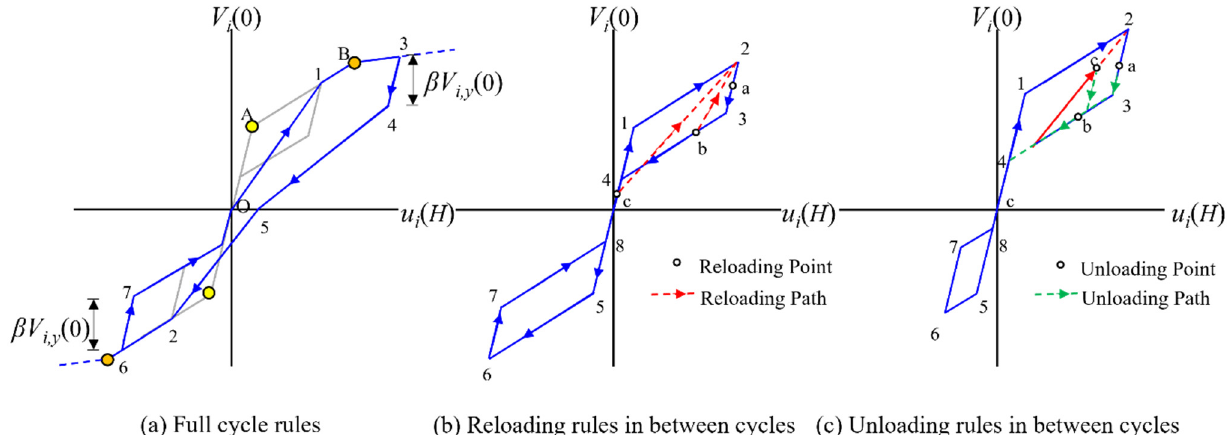
Figure 10. Hysteretic rules [39].